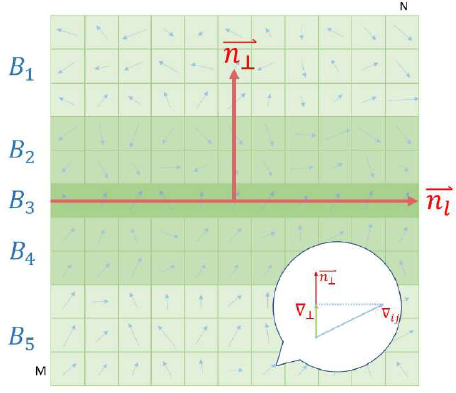
Figure 6. Banded line-support region for line l . BGM i indicates the weighted mean vector of ∇ ⊥ , the gradient projected on the direction of the normal vector.